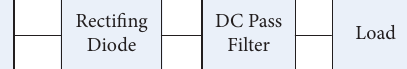
Figure 17: Rectifying circuit